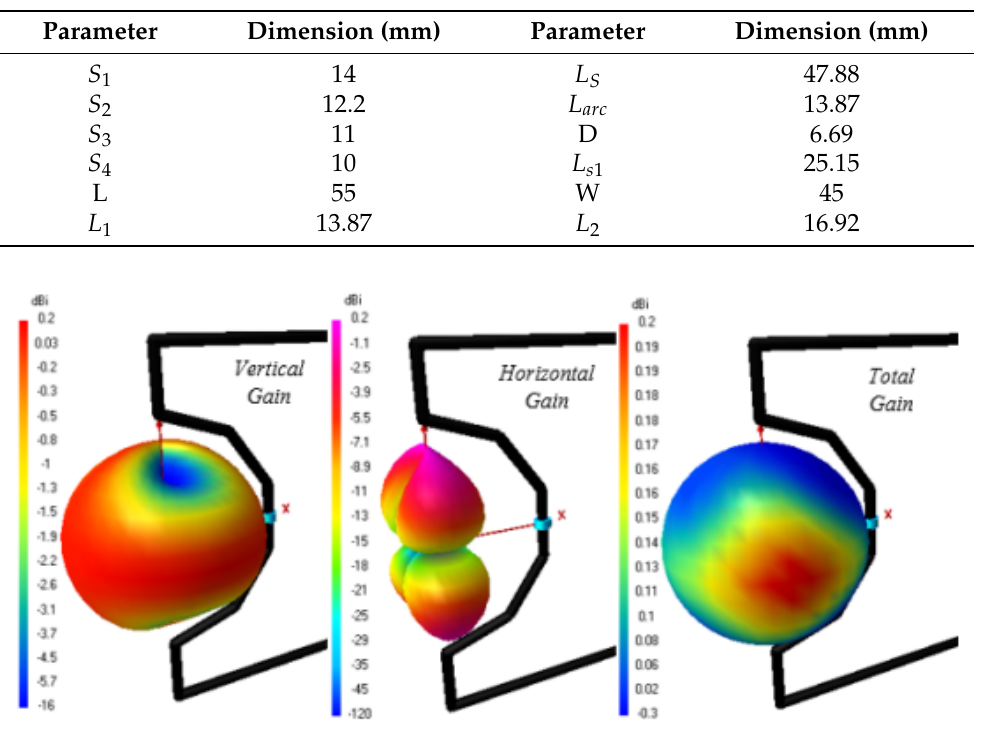
Table 1. Proposed Antenna Dimensions.